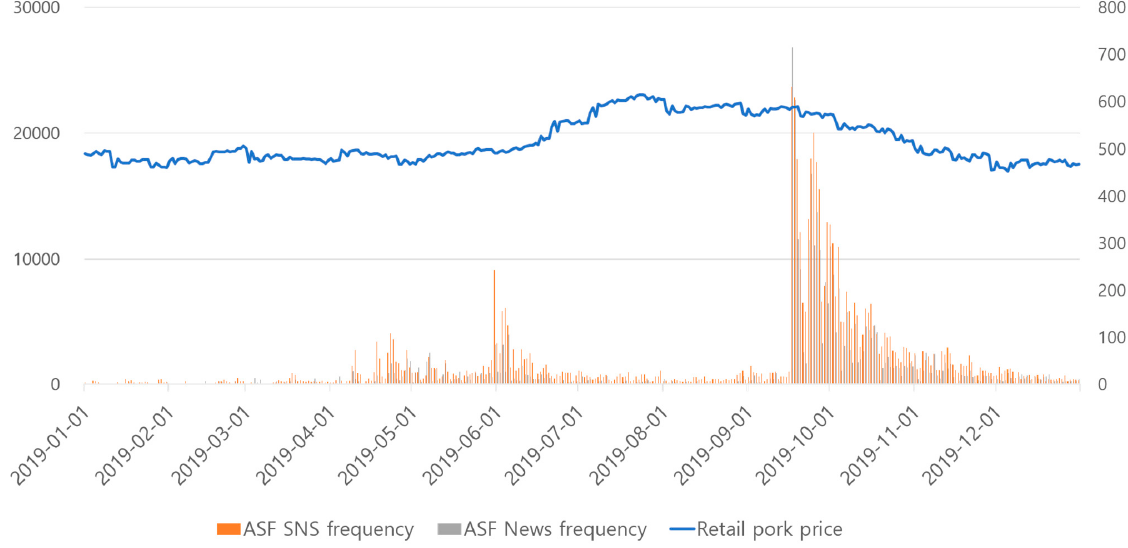
Figure 1. Trends in retail pork prices, African Swine Fever (ASF)-related news and SNS frequencies in 2019. The x axis indicates time and the y axis indicates retail pork price and frequency.